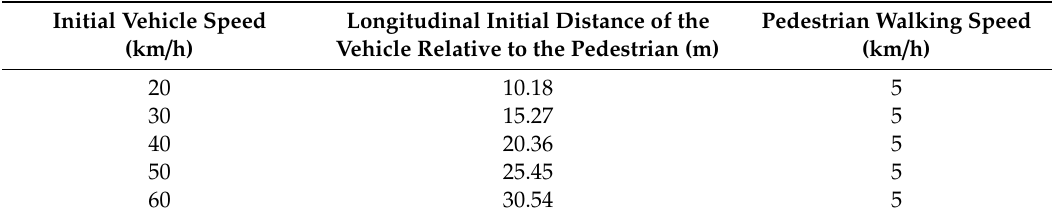
Table 12. The CVNA (Car-to-VRU Farside Adult)-25 simulation conditions.